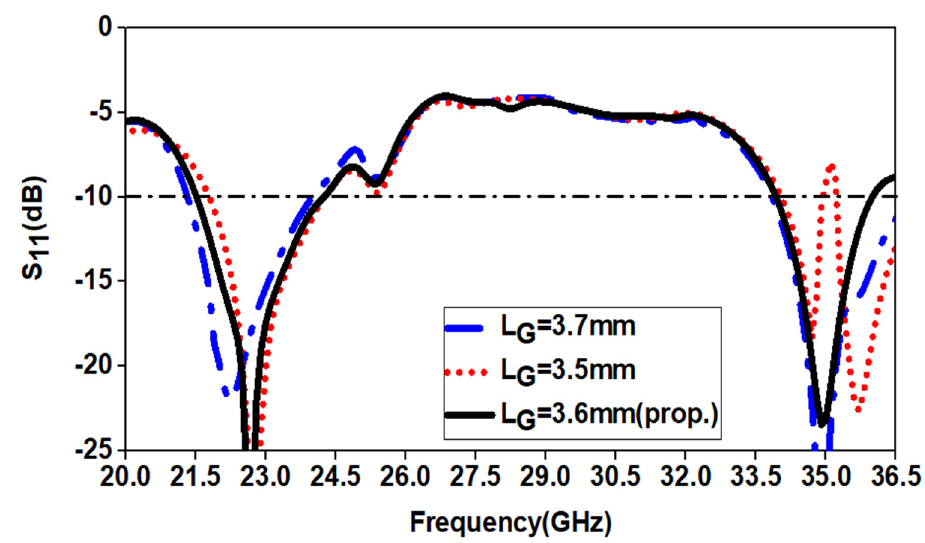
Figure 11. Analysis of variation in the length of first type ground cut L G .